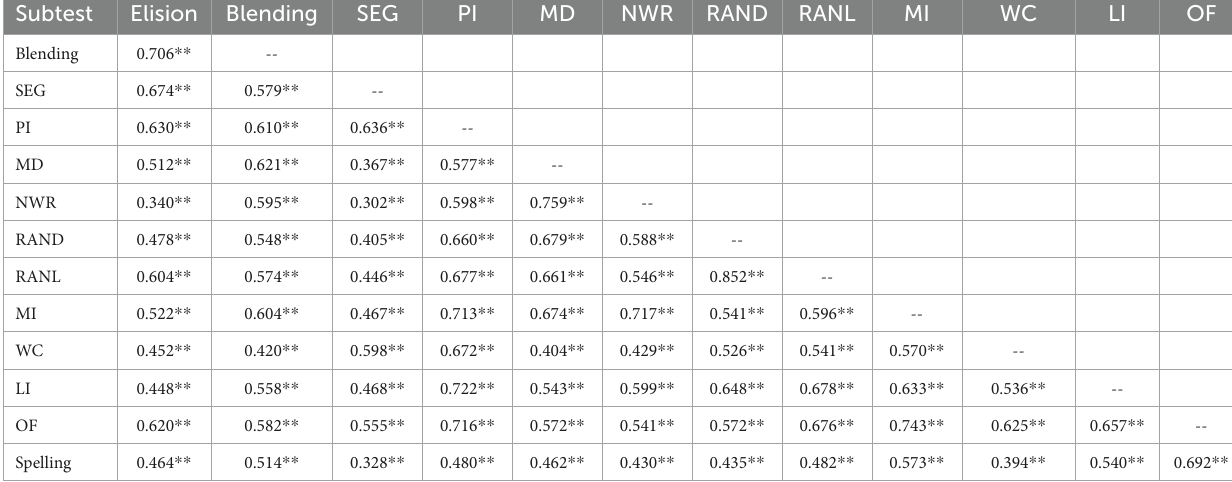
TABLE 3 Pearson’s linear correlation coefficients among the subtests of TEALS grade